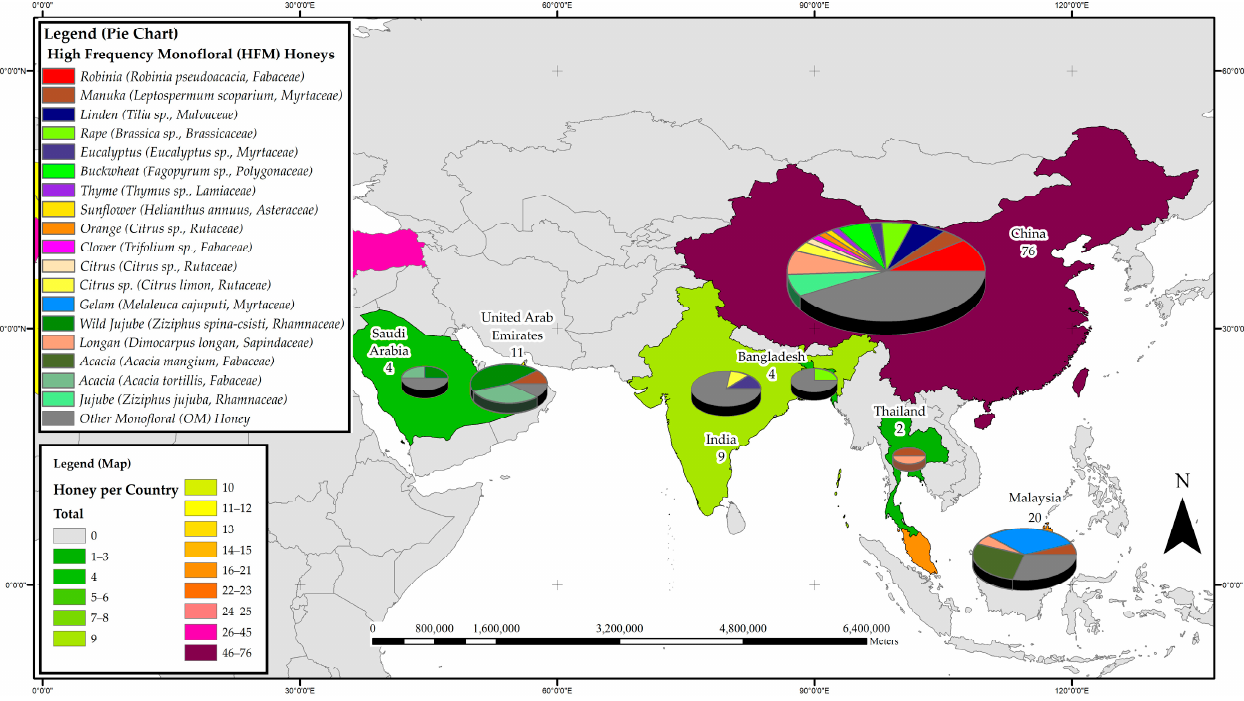
Figure 4. Most frequently studied honeys with respect to their phenolic profile in the Americas.